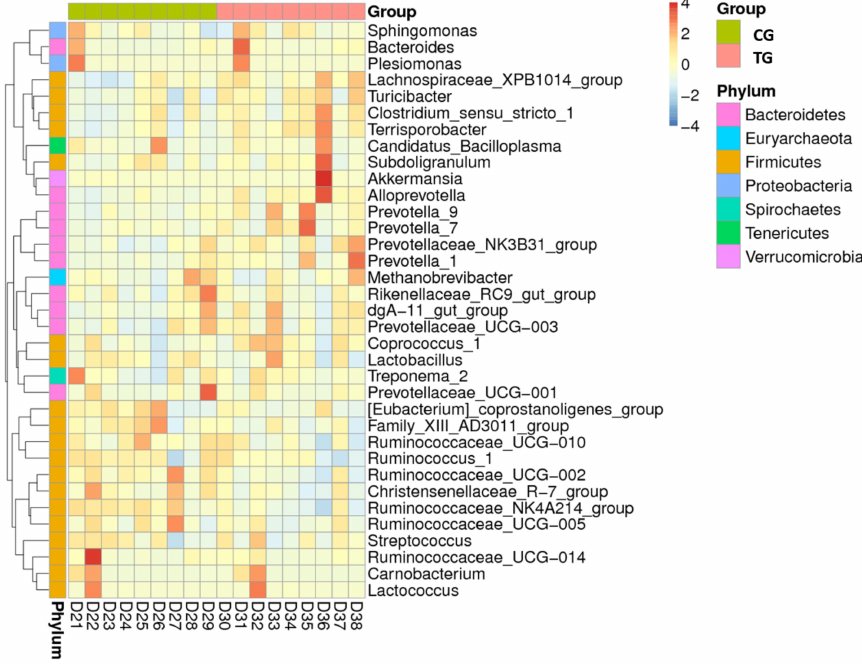
Figure 2. Heat map of relative differences of the 35 most common genera in the fecal samples of pigs fed a normal diet (CG) and a diet supplemented with protected sodium butyrate (TG). A value of − 4 represents the disappearance of a particular genus, while a +4 value indicates that it increased from the initial value of